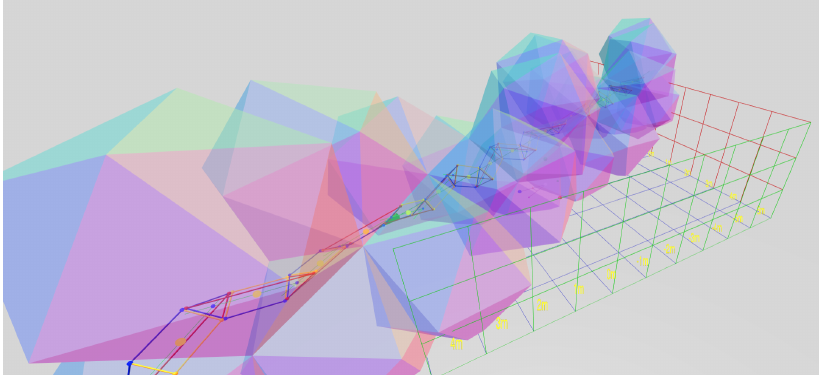
Figure 19. Two Strands.